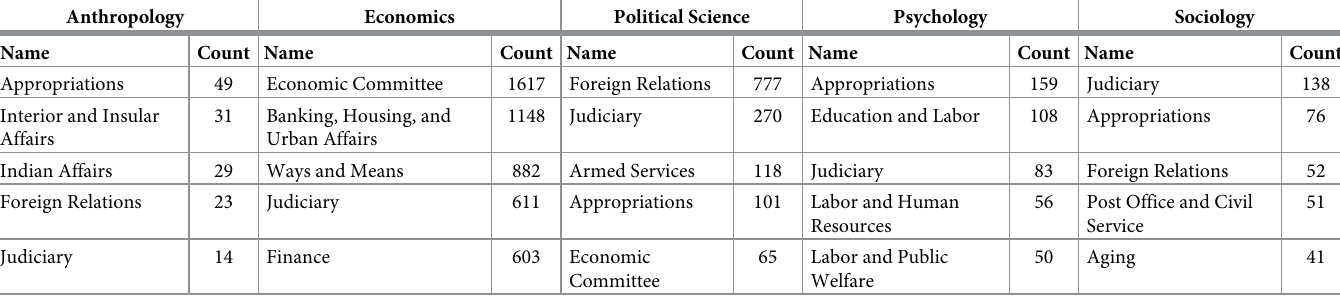
Table 1. Most common committees and counts for each